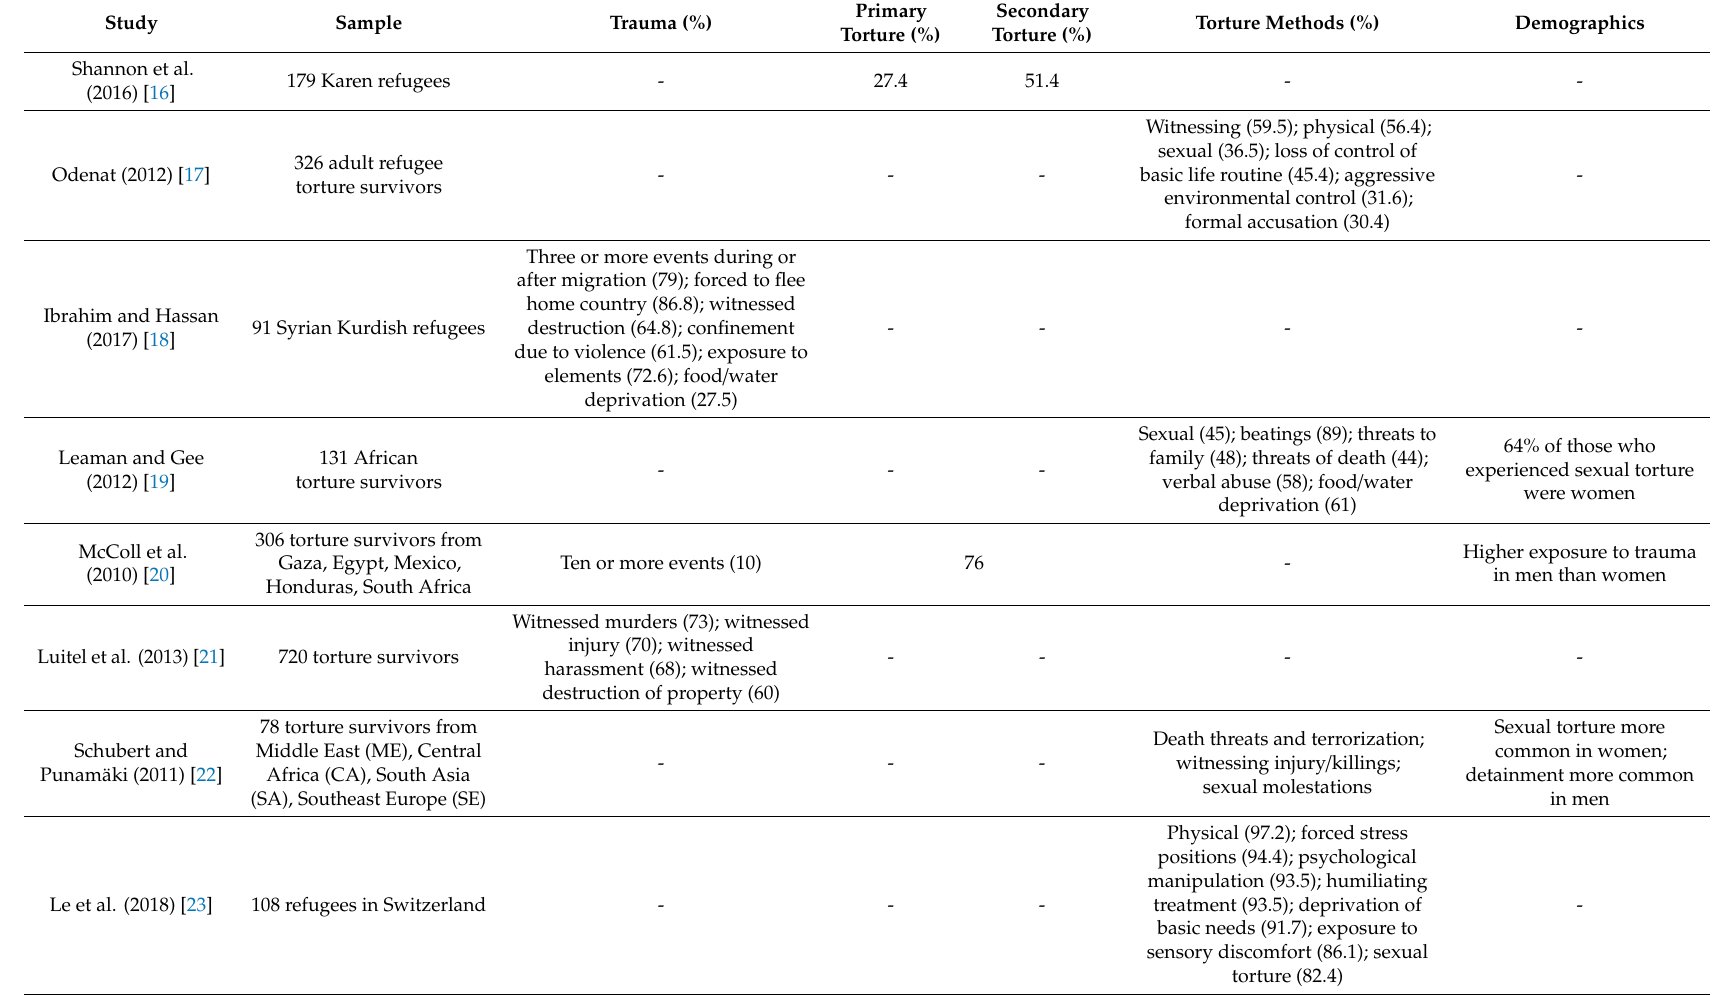
Table 2. Characteristics of